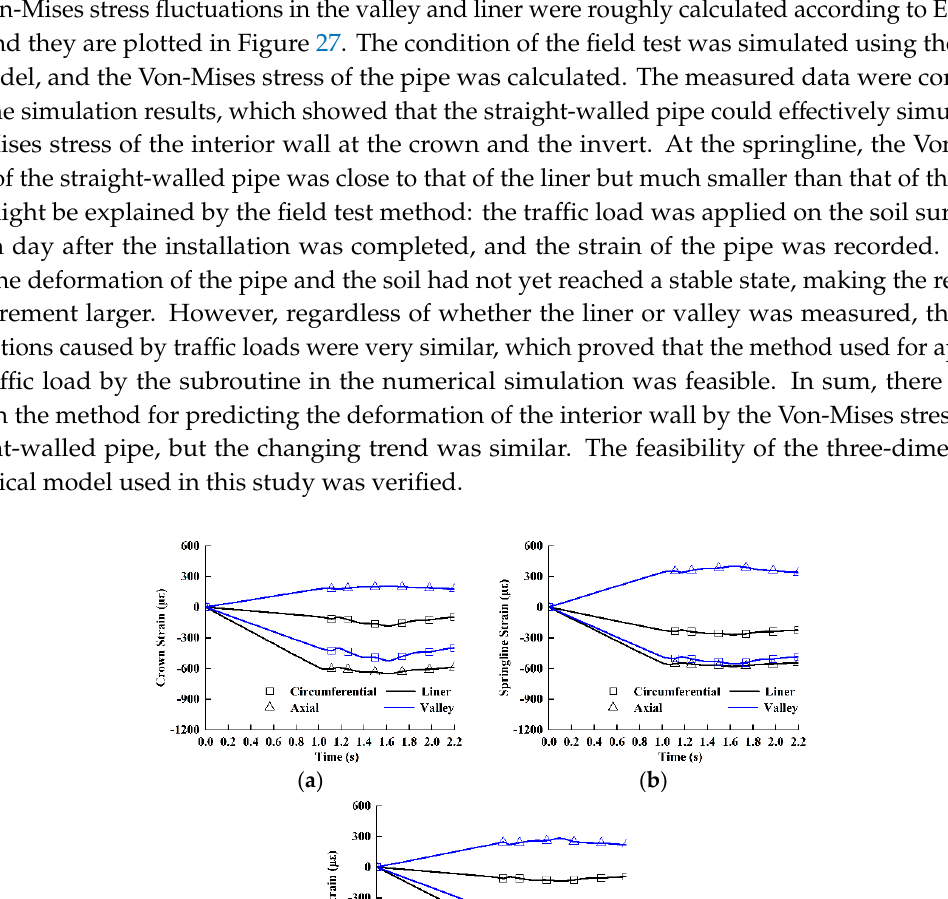
Table 8. Physical and mechanical properties of the field test soil.